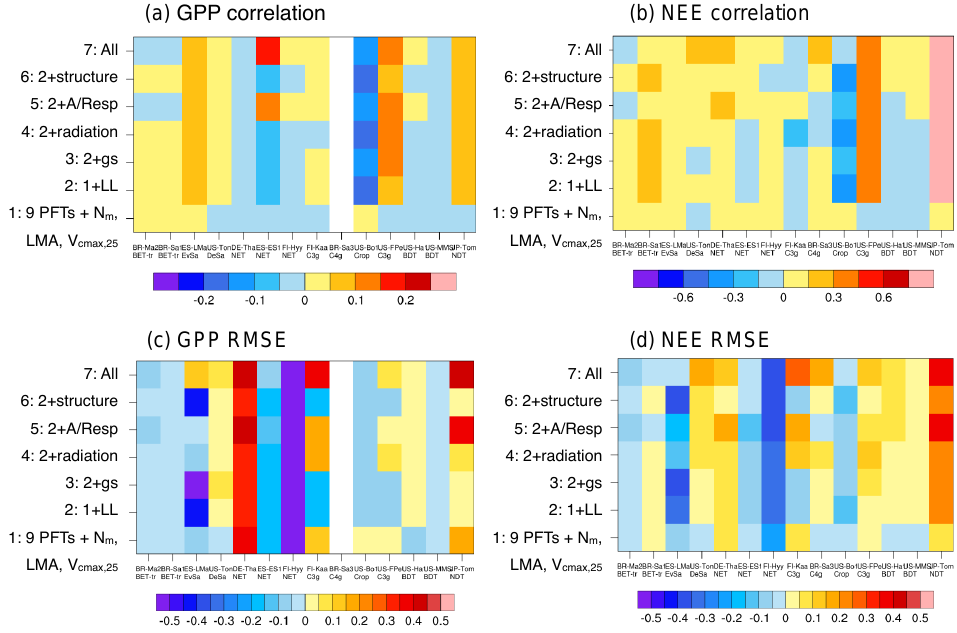
Figure 4. Relative changes in daily RMSE (Eq. 24) and monthly correlation coefficients (Eq. 25) for the JULES experiments in Table 4 compared to JULES5. Yellows and reds indicate an improvement in JULES compared to the FLUXNET